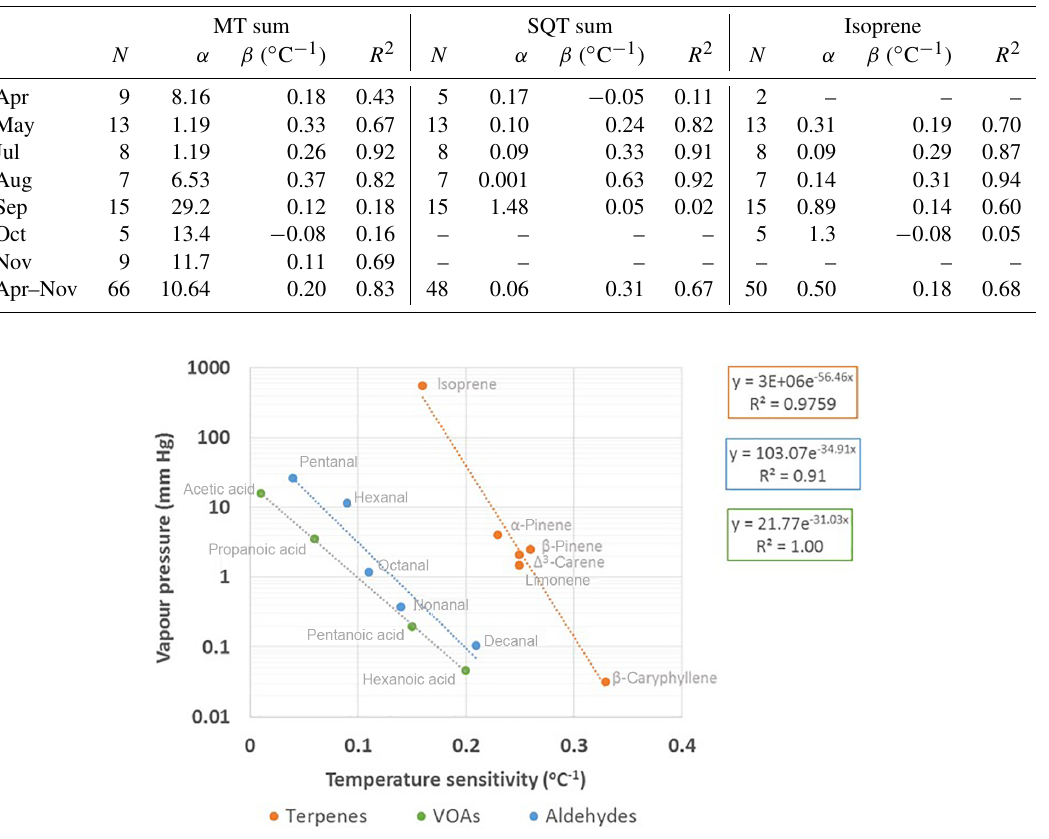
Table 4. Characterisation of the temperature dependence of the isoprenoid concentrations with intercept ( α ), temperature sensitivity ( β ) and correlation ( R 2 ) of the daily mean concentrations of MT sum and SQT sum measured at SMEAR II in different months in 2016. N is the number of daily means. The fitted curves were exponent functions y = αe βx , where y is the concentration, x is the temperature and β is the temperature sensitivity.